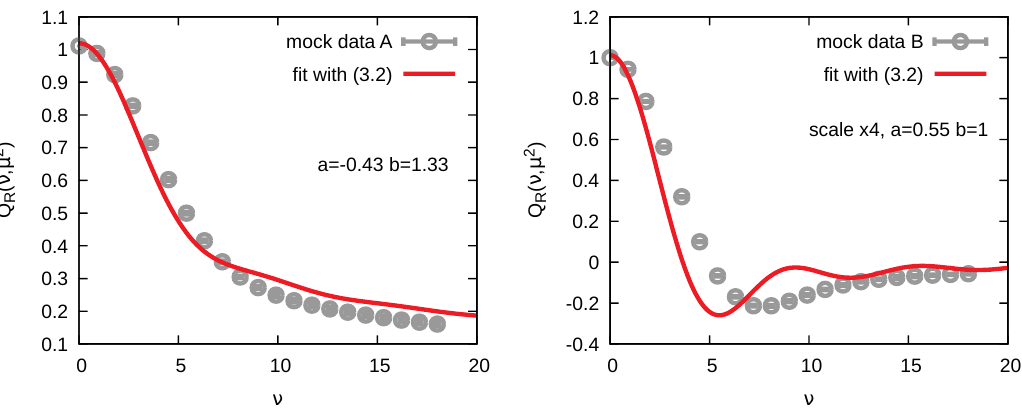
Figure 12 . Mock data ( (cid:23) ) in the interval I 3 from (left) realistic PDF data [mock scenario A] Q and (right) a modi(cid:12)ed scenario with the PDF vanishing at the origin [mock scenario B]. In red we show the corresponding best (cid:12)t of the noisy data with eq.